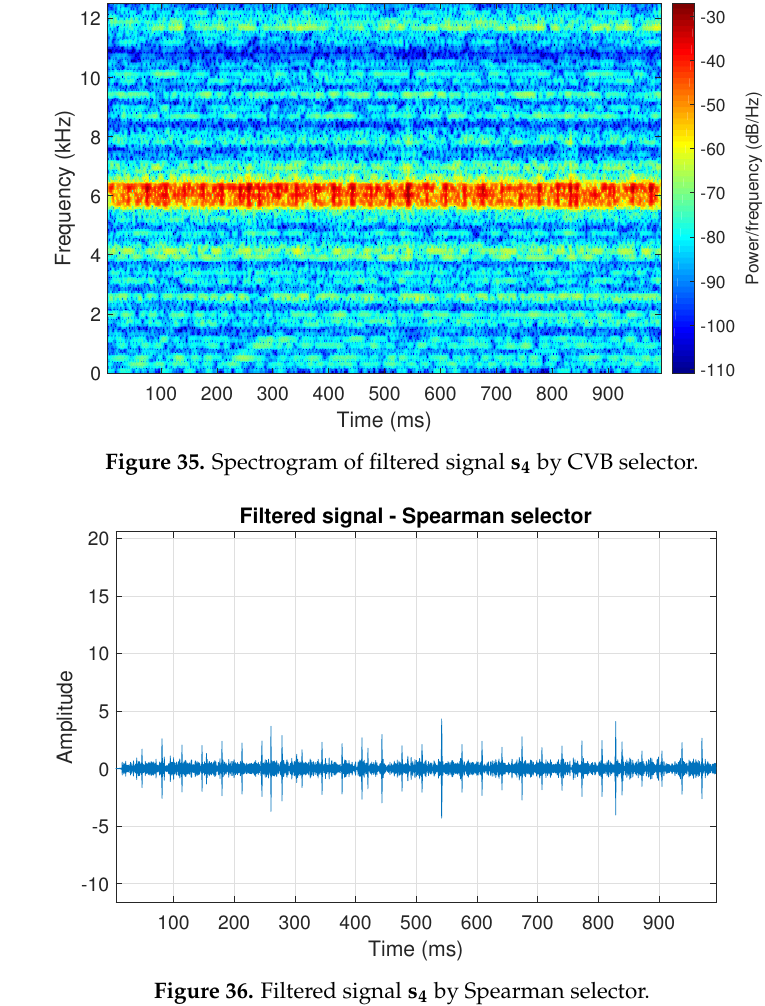
Figure 36. Filtered signal s 4 by Spearman selector.